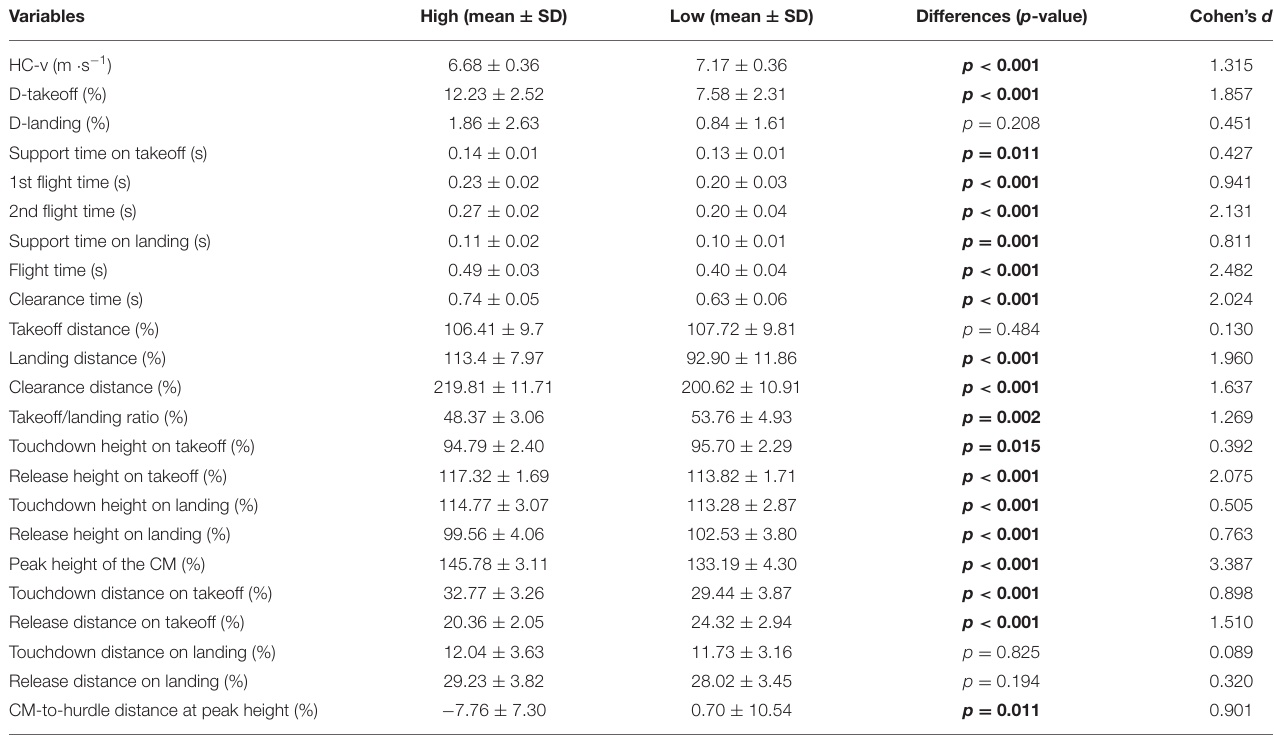
TABLE 1 | Values of the variables during hurdle clearance (HC) at each hurdle height and differences between the two conditions.